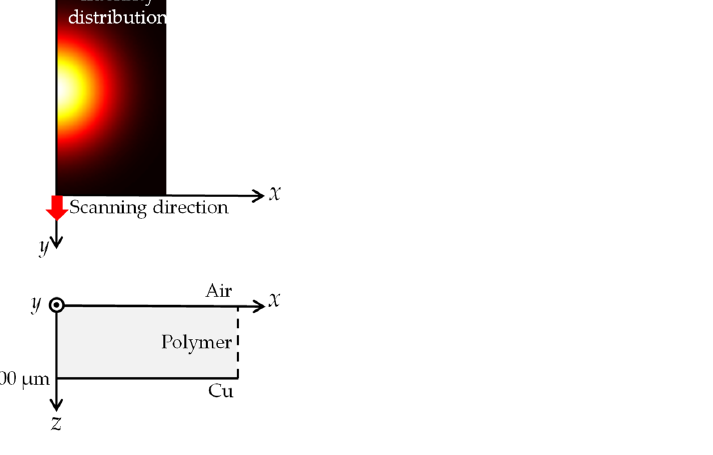
Figure 6. Simulation schematic of the laser ‐ scanning direction and the calculation area. Table 2. The physical property values used in the simulation.